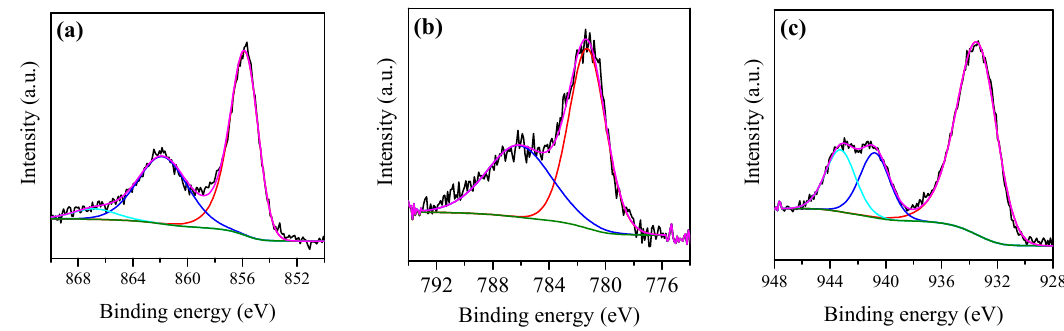
Figure 3. ( a ) Ni 2p 3/2 XP spectra for 10Ni − Al calcined sample, ( b ) Co 2p 3/2 XP spectra for 10Co − Al calcined sample and ( c ) Cu 2p 3/2 XP spectra for 10Cu − Al calcined sample.